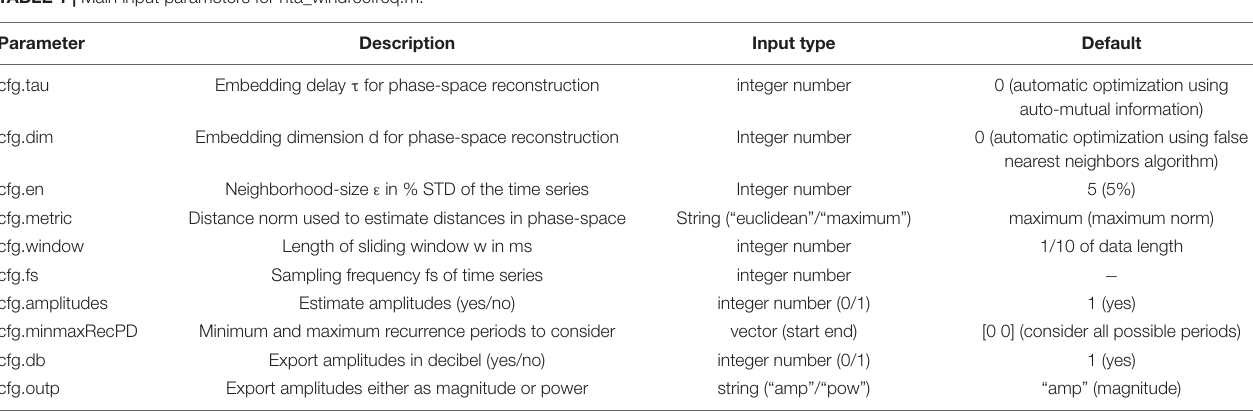
TABLE 1 | Main input parameters for